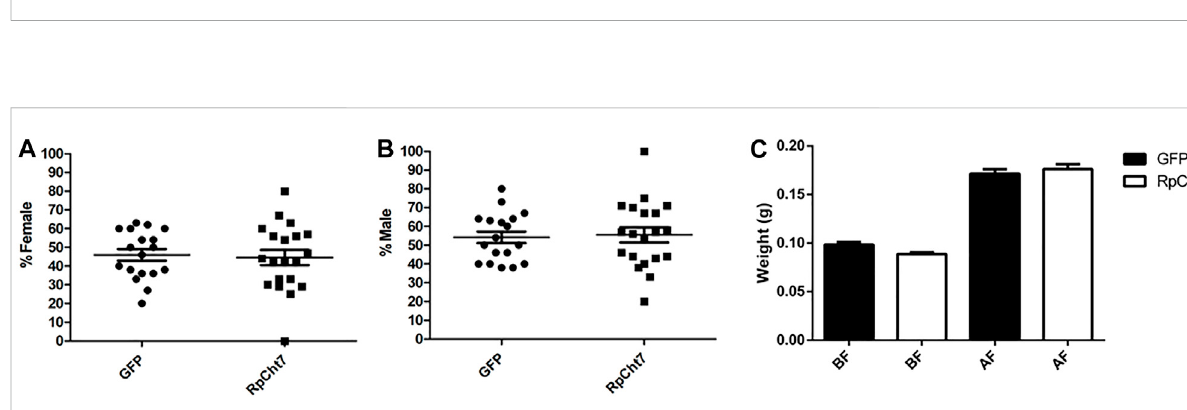
FIGURE 9 Molting phenotype. (A) Percentage of fi fth-instar nymphs that molted to adults after injection with dsRNA and blood meal. (B) Image of defective phenotype; 1: Insect trapped in exuvia 2: Deformed insect. (C) Percentage of all molting defects. GFP: injected with ds GFP ; RpCht7: injected with ds RpCht7 . The experiment was performed 8 times with groups of 20 – 30 insects each. No signi fi cant differences were found between GFP and RpCht7 groups ( p > 0.05; T-test).